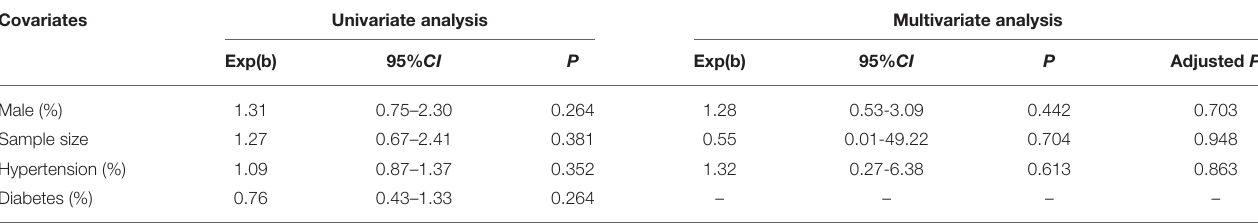
TABLE 3 | The results of meta-regression analysis. Covariates